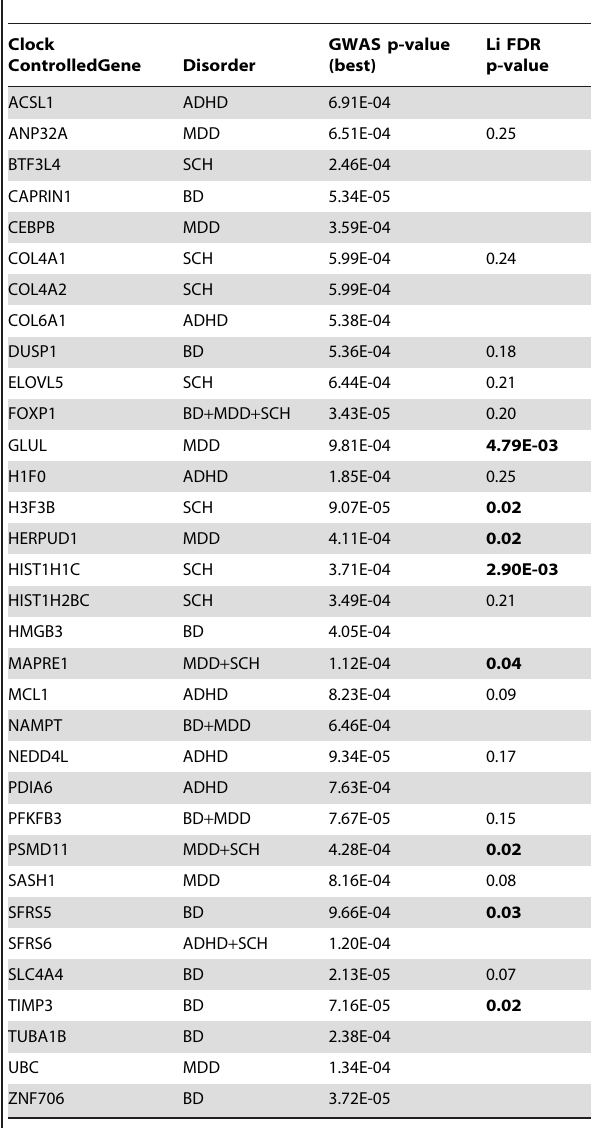
Table 4. Pervasively rhythmic clock-controlled genes associated with BD-spectrum